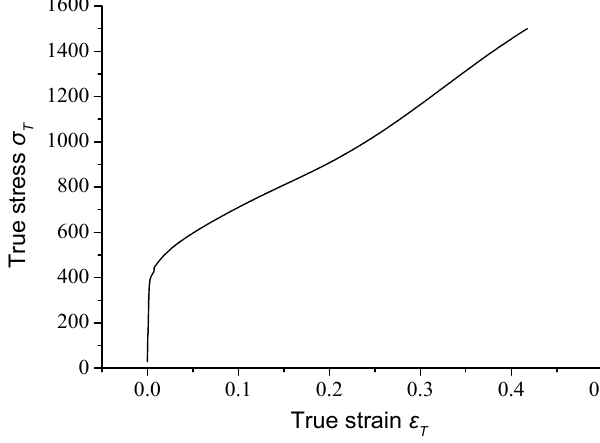
Figure 3. True stress–strain curve of the GH1140 superalloy.